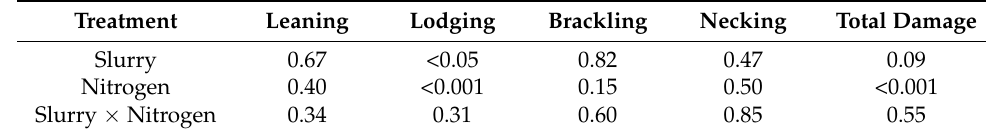
Table 12. 2016/17 REML analysis F-values of spring barley damage pre-harvest.